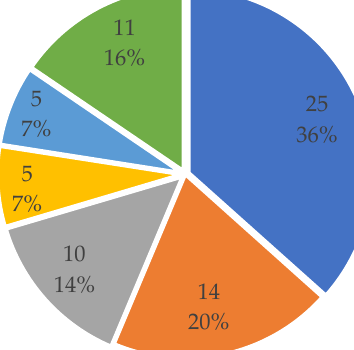
Figure 3. Percentages of different kinds of activities compared to the whole occurrence of activities of bioactive diterpenes derived from marine fungi.